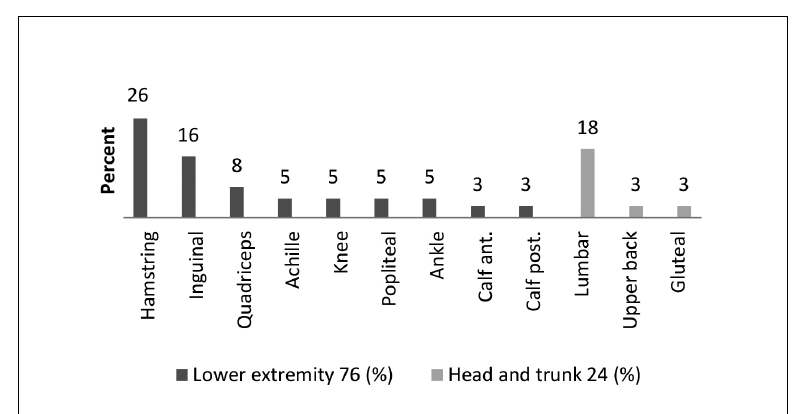
Figure 4. Distribution of injuries by degree of severity (N =